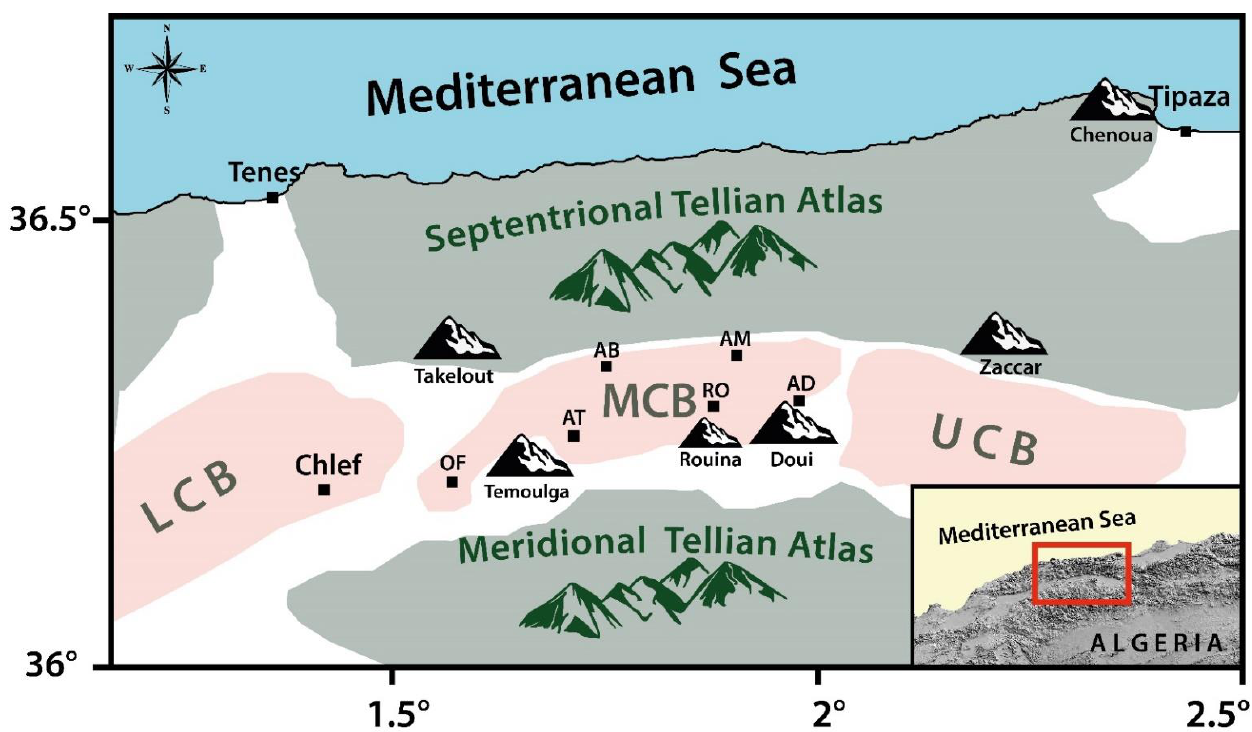
Figure 1. Situation of the Middle-Chelif Basin. LCB: Lower-Chelif Basin. MCB: Middle-Chelif Basin. UCB: Upper-Chelif Basin. OF: Oued-Fodda. AB: El-Abadia. AT: El-Attaf. AM: El-Amra. RO: Rouina. AD: Ain-Defla.